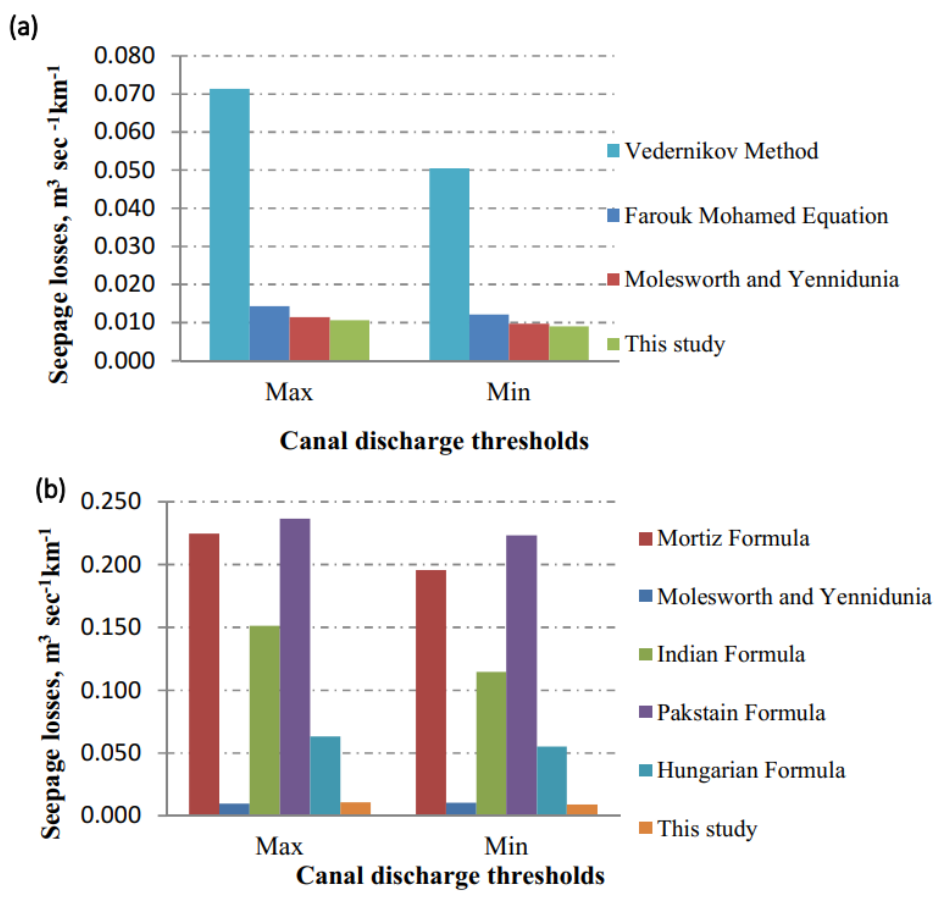
Figure 5. Canal seepage losses from the earth canal using ( a ) analytical formulas, ( b ) empirical formulas.